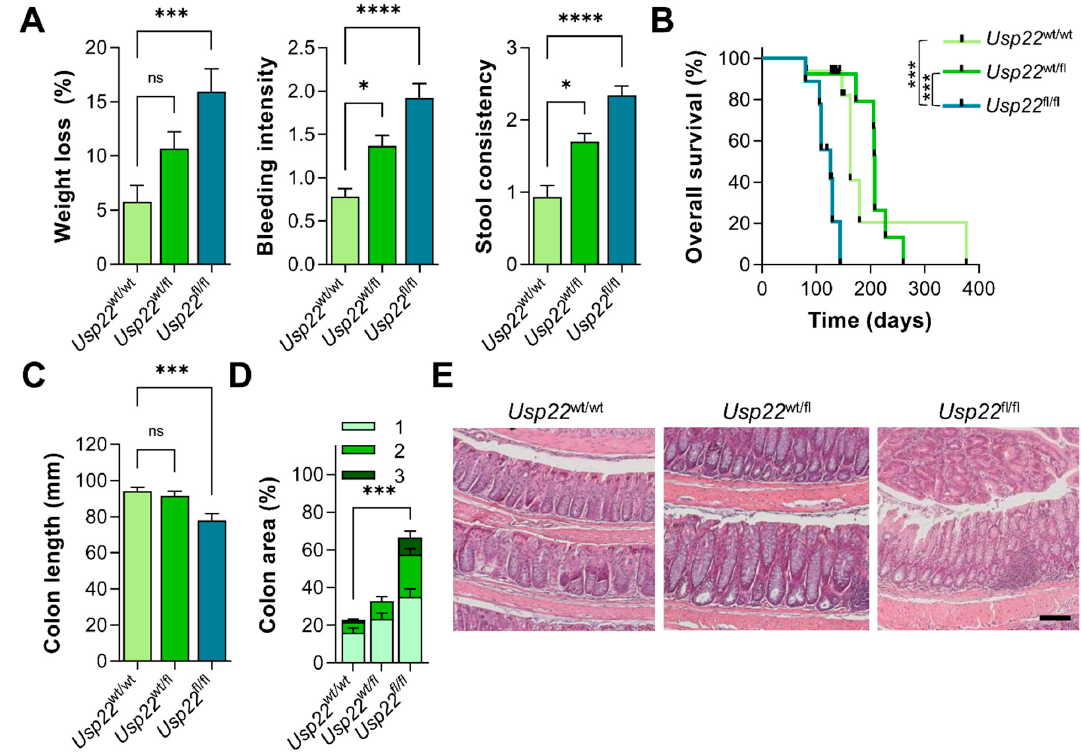
Figure 3. Inflammation-associated symptoms were aggravated in Apc -mutant Usp22 fl/fl mice. ( A ) Average weight loss, scores for bleeding intensity and stool consistency were significantly increased in Apc 1638N/+ , Villin-CreER T2 , Usp22 fl/fl mice compared to Usp22 wild type controls. ( B ) These Usp22 -deficient animals displayed reduced overall survival. ( C ) To assess phenotypic and histological features, wild type and heterozygous controls were sacrificed at the same age that Usp22 -deficient mice were sacrificed. Consistent with a higher disease activity, Usp22 fl/fl mice displayed decreased colon lengths. ( D ) Analysis of H&E-staining of colon sections revealed elevated inflammation-associated epithelial damage in Usp22 fl/fl mice. Statistical analyses are based on the H-score. ( E ) Representative images of H&E-stained colon sections. Scale bar: 100 μ m. Mean ± SEM. One-way ANOVA. * p ≤ 0.05, *** p ≤ 0.001, **** p ≤ 0.0001.